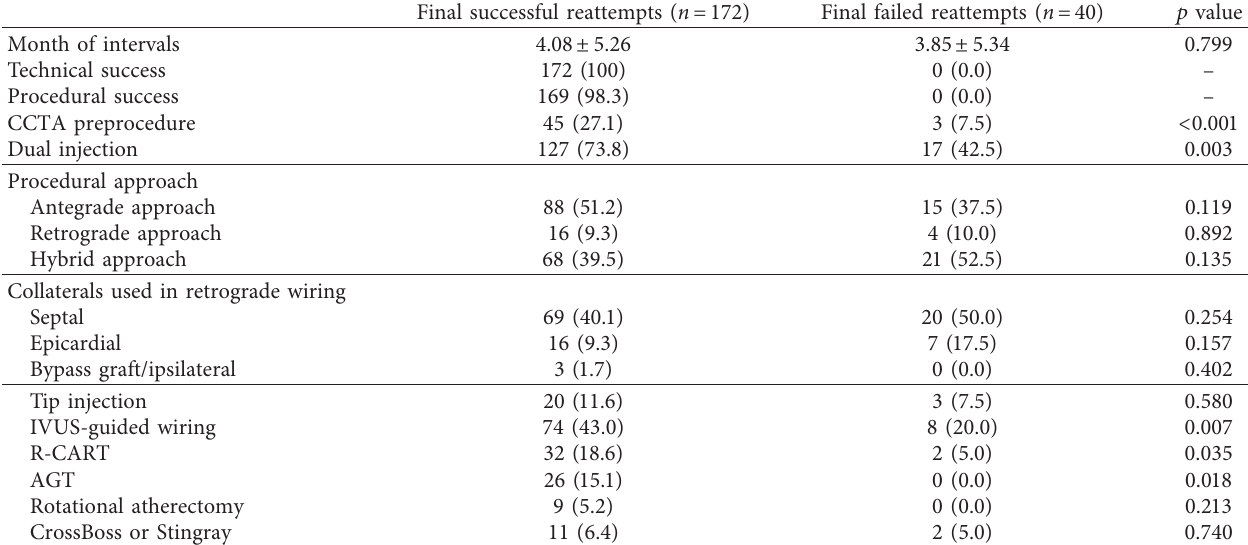
Table 3: Strategies and differences between final successful and failed cases.